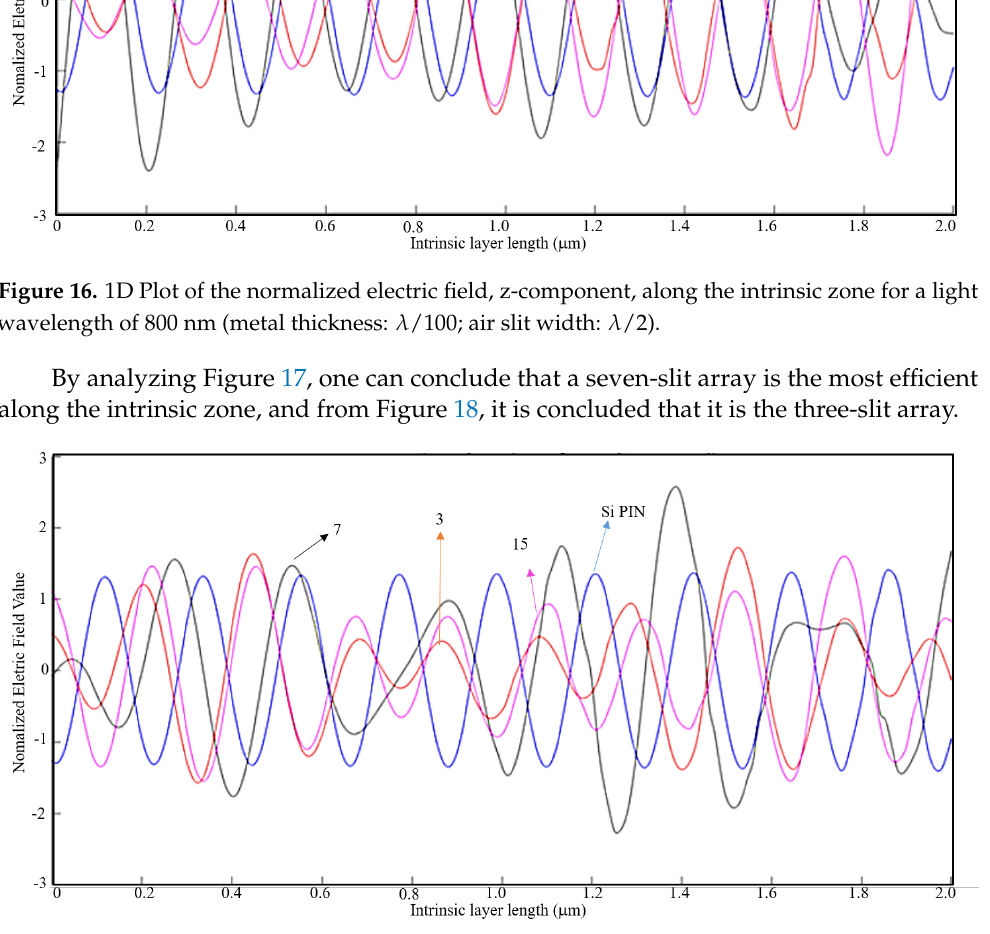
Figure 17. 1D Plot of the normalized electric field, z-component, along the intrinsic zone for a light wavelength of 800 nm (metal thickness: λ /100; air slit width: λ